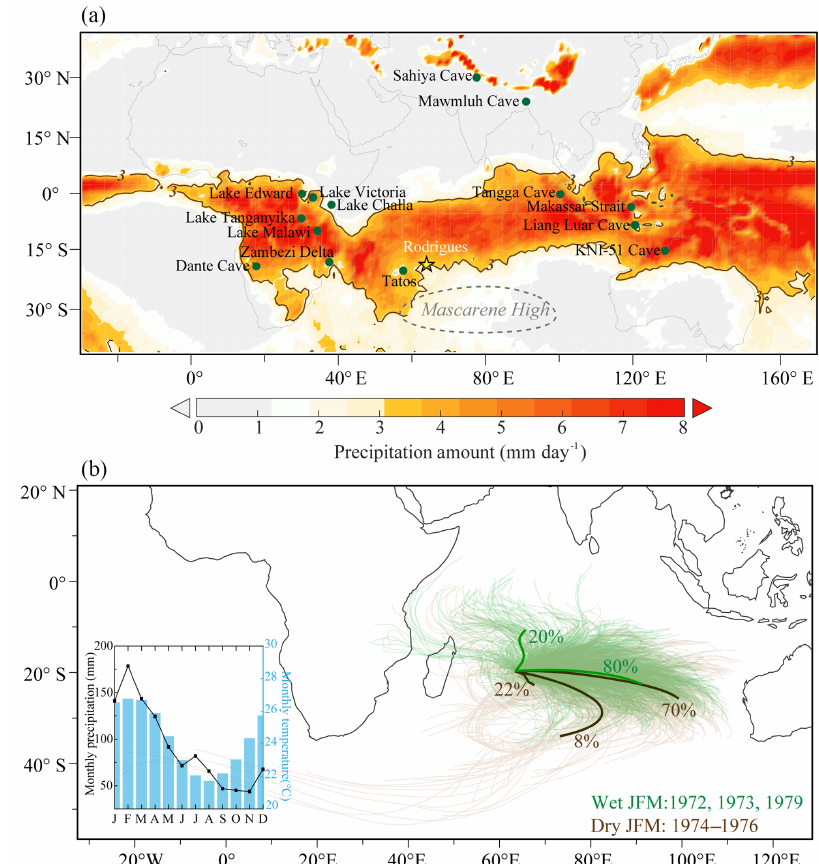
Figure 1. Proxy locations and climatology. (a) Mean January to March (JFM) precipitation from the Tropical Rainfall Measuring Mission (TRMM) (https://trmm.gsfc.nasa.gov/, last access: 2 December 2018) averaged over the period from 1998 to 2014. The shaded area bounded by solid brown lines (3mmday − 1 isohyet) depicts the mean position of the ITCZ. The dashed line shows the mean position of JFM 850hPa geopotential height marking the location of the Mascarene High. The locations of Rodrigues Island (yellow star, this study) and other proxy sites (green dots) discussed in the text are also shown. (b) Four times daily, low-level ( ∼ 850hPa) JFM air parcel back-trajectory (120h) composites for anomalously wet (green) and dry (brown) years. Trajectories were computed using the NOAA HYSPLIT model (Draxler and Hess, 1998) using NCEP/NCAR reanalysis data (Kalnay et al., 1996). Bold lines indicate main cluster tracks associated with trajectories for wetter (green) and drier (brown) years. Inset shows mean monthly rainfall and temperature at Rodrigues averaged over the period of 1951 to